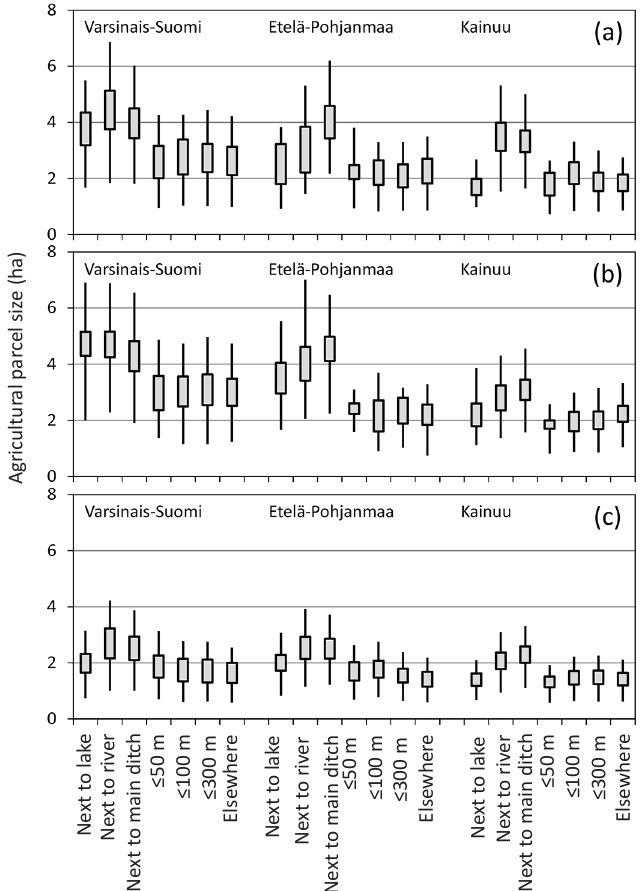
Fig. 8. Differences between major and minor production regions in agricultural parcel size devoted to spring wheat (a), rapeseed (b) and grass crops (c). The upper part of the line indicates upper quartile, the lower part of line lower quartile, the top of the box mean parcel size (ha) and the bottom of the box median for field